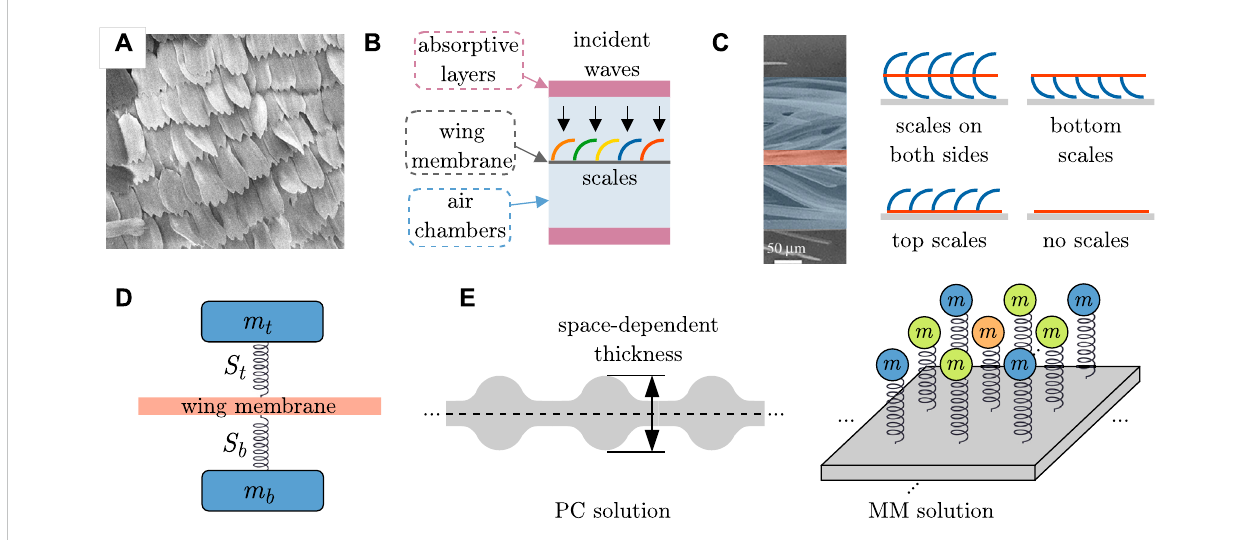
FIGURE 7 Moth wing scales and related bioinspired systems. (A) Individual scale observed using scanning electron microscopy [adapted from (Zeng et al., 2011)]. (B) Numerical testing using an arrangement of scales with varying resonant frequencies in a unit cell (Neil et al., 2020). (C) Cross section of wing membrane (red, middle) with scales (blue, top and bottom regions) and con fi gurations for testing of re fl ectance using a circular metal disc (grey), wing membrane(red),andscalesatspeci fi cregions(blue)[adaptedfrom(Neiletal.,2022)]. (D) Modelofawingmembranecoveredbyscales,represented by a plate with locally resonant elements with masses m t ( m b ) connected to the top (bottom) surface by a stiffness S t ( S b ) (Wang et al., 2022). (E) Representations of proposed panel solutions, considering either a space-dependent thickness panel (PC solution) or a unit cell with a set of distributed spring-mass resonators presenting four-fold symmetry (MM solution) (Dal Poggetto et al.,